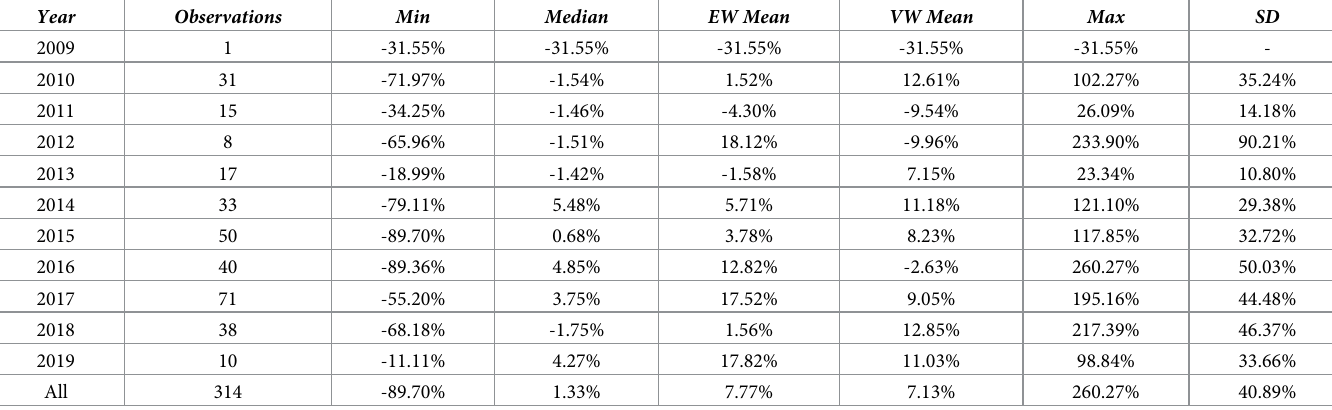
Table 3. Descriptive statistics of four-week returns on the issuing firms’ securities.